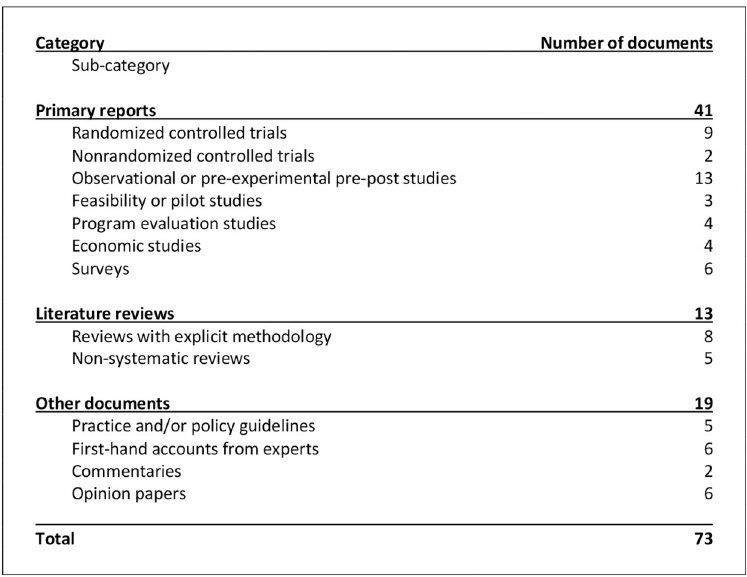
Fig 2. Number of documents included by publication